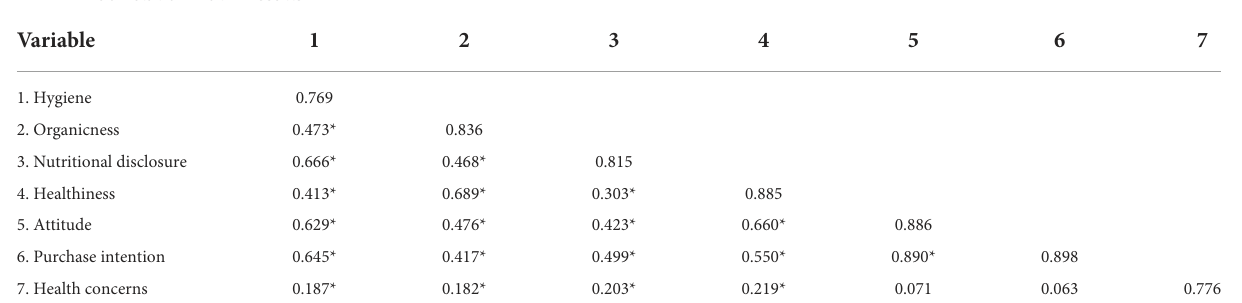
TABLE 4 Correlation matrix results.